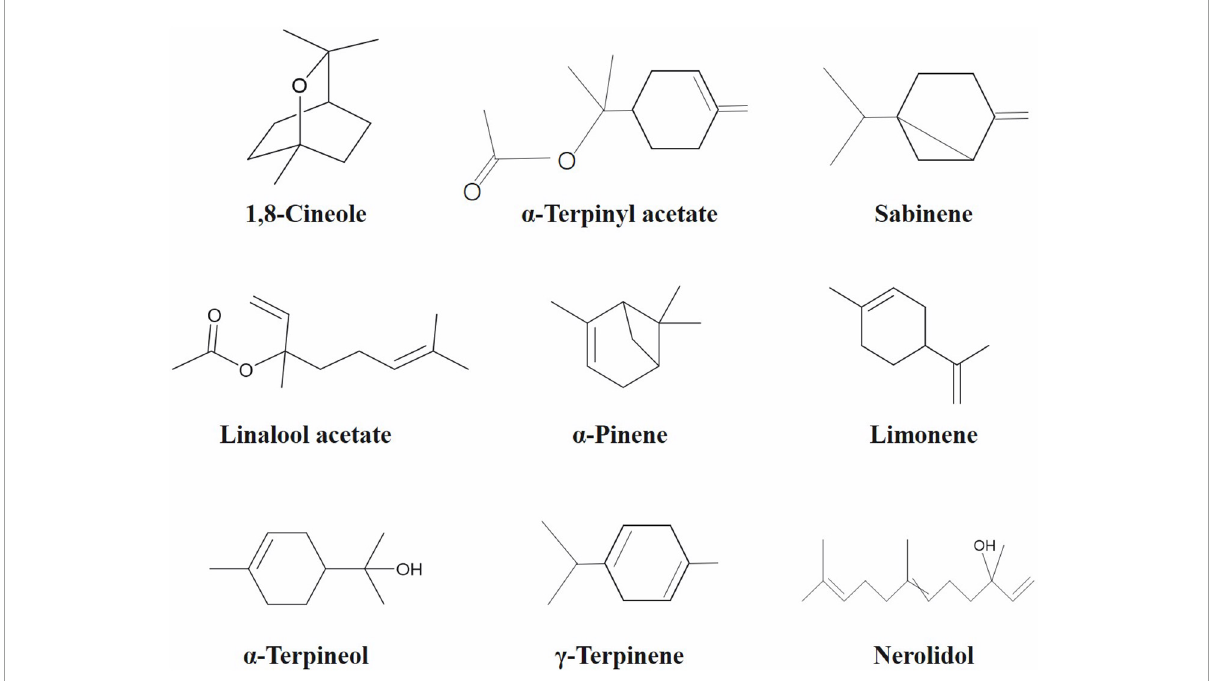
FIGURE2 Chemical structures of major bioactive phytochemicals identified in cardamom.